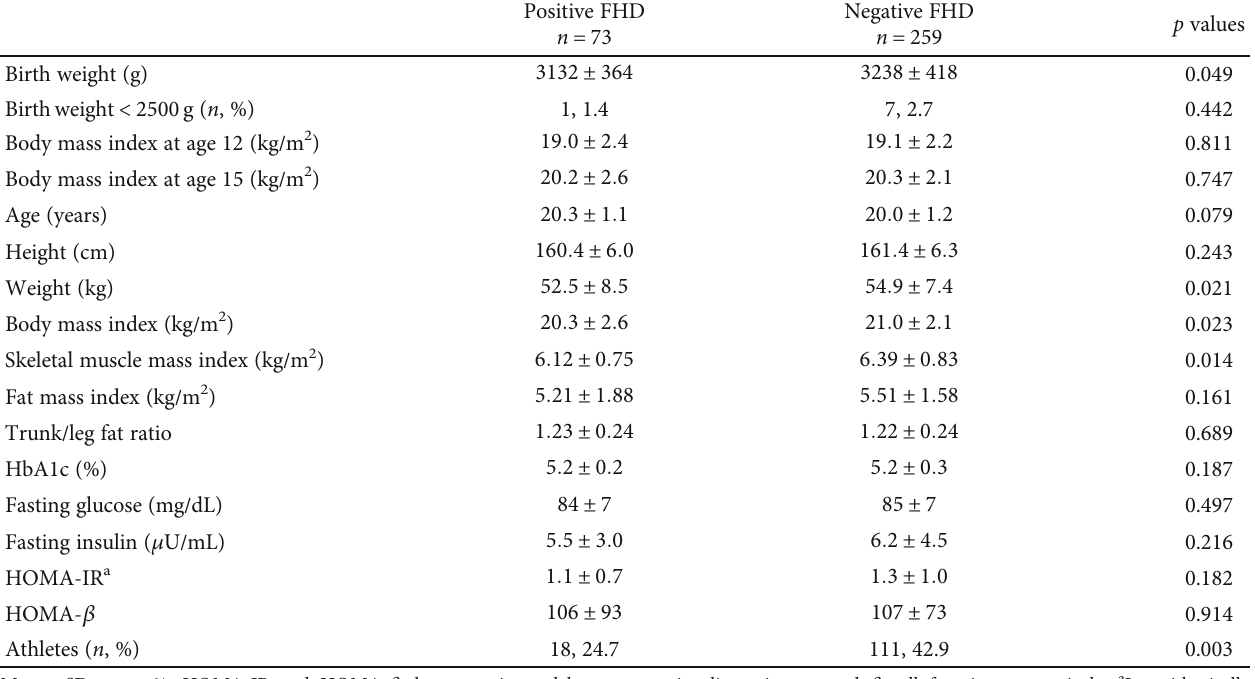
Table 1: Characteristics of young Japanese women in the presence and absence of family history of type 2 diabetes (FHD).